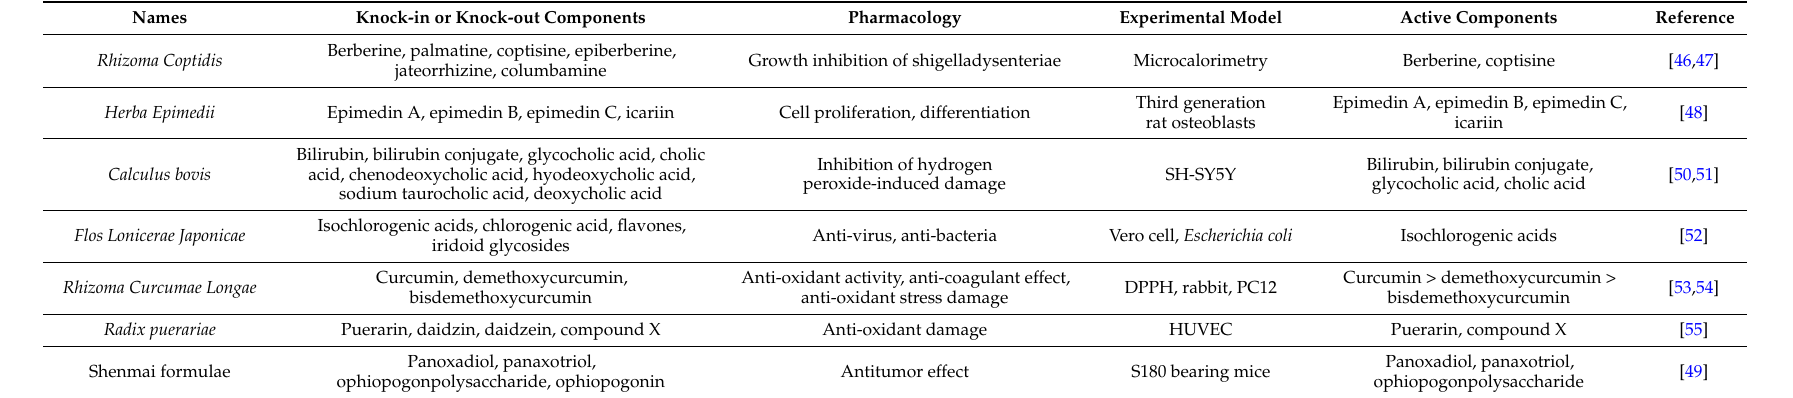
Table 2. Study on the knock-in and knock-out target components in